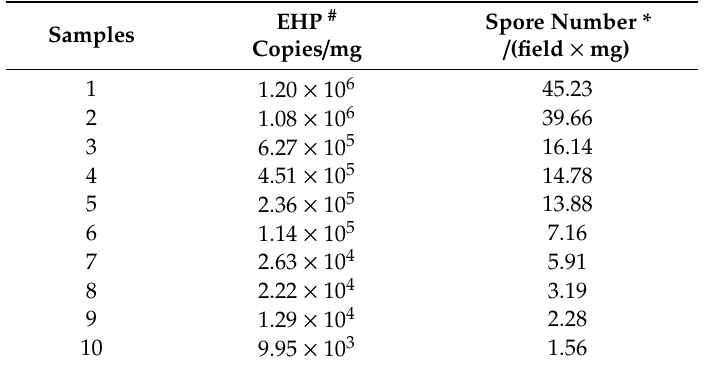
Table 4. Integrated analysis of microscopy and PTP2-qPCR for EHP